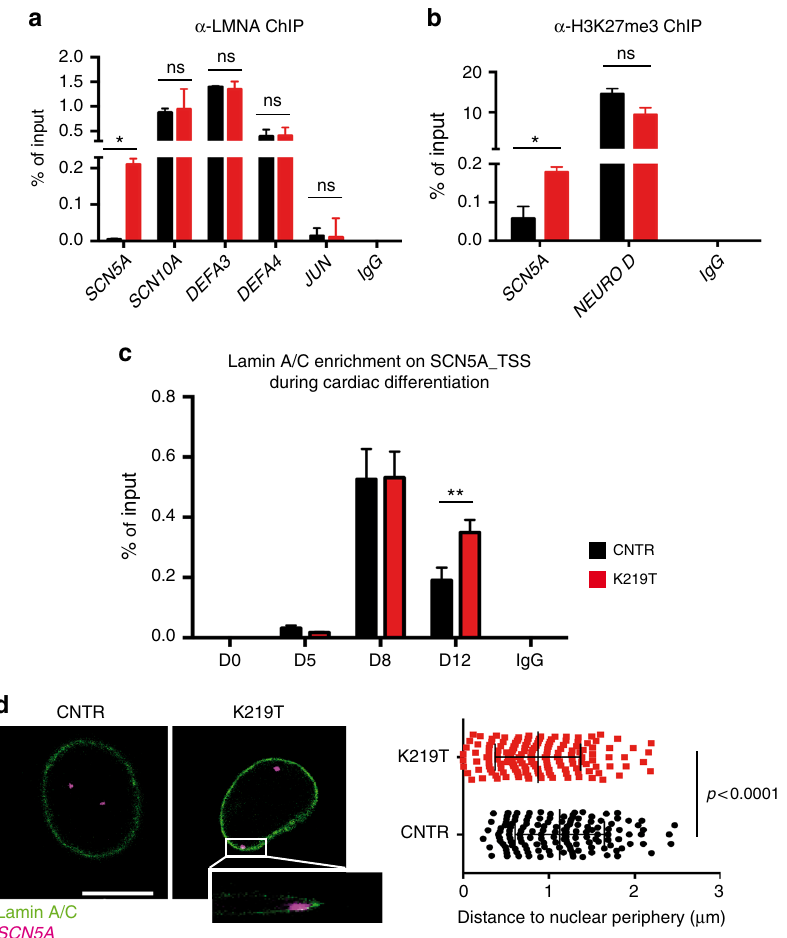
Fig. 5 Epigenetic modulation of SCN5A gene expression. a , b ChIP analyses in CNTR-CMs and K219T-CMs with antibodies against Lamin A/C ( a ) and H3K27me3 ( b ) targeting the SCN5A genomic region. Data are presented as a percentage of input chromatin precipitated and relative to 2 independent iPSC clones from each subject. ChIP for Lamin A/C, indicating increased binding of Lamin A/C to the promoter region of the SCN5A gene in K219T-CMs; no enrichment was detectable for JUN , used as a negative control region for the ChIP experiment; SCN10A , DEFA3 , and DEFA4 were used as positive control regions for the ChIP experiments, and they show comparable enrichment of Lamin A/C in CNTR-CMs and K219T-CMs ( a ). ChIP for the histone modi fi cation H3K27me3, showing an enrichment of the repressive histone mark at the SCN5A gene promoter in K219T-CMs, supporting the reduced expression of the gene detected in these cells; NEURO D was used as positive control region for the antibody ( b ). c ChIP against Lamin A/C, showing the dynamics of Lamin A/C enrichment at the transcription start site (TSS) of SCN5A during cardiac differentiation (from days 0 to 12). The graph is relative to one representative experiment (out of three). For this analysis, two-way ANOVA was used for the statistic test. ** p < 0.01. d 3D-FISH for Lamin A/C (green) and SCN5A (magenta) conducted with an antibody and a DNA probe, respectively. Left: representative images of nuclei from CNTR and K219T-CM preparations (Scale bar: 9 μ m). Magni fi ed box shows the colocalization of the SCN5A probe at the nuclear lamina. Right: Analysis of the distance from the nuclear lamina, showing preferential localization of the SCN5A probe (magenta) at the nuclear periphery in K219T-CMs vs. CNTR. Quanti fi cation was carried out using a speci fi c plug-in of the ImageJ software (CNTR-CMs: n = 72 cells; K219T-CMs: n = 82 cells; p < 0.0001). All values are reported as means ± SD, if not differently speci fi ed. * p < 0.05; ** p < 0.01, ns, not signi fi cant (unpaired t